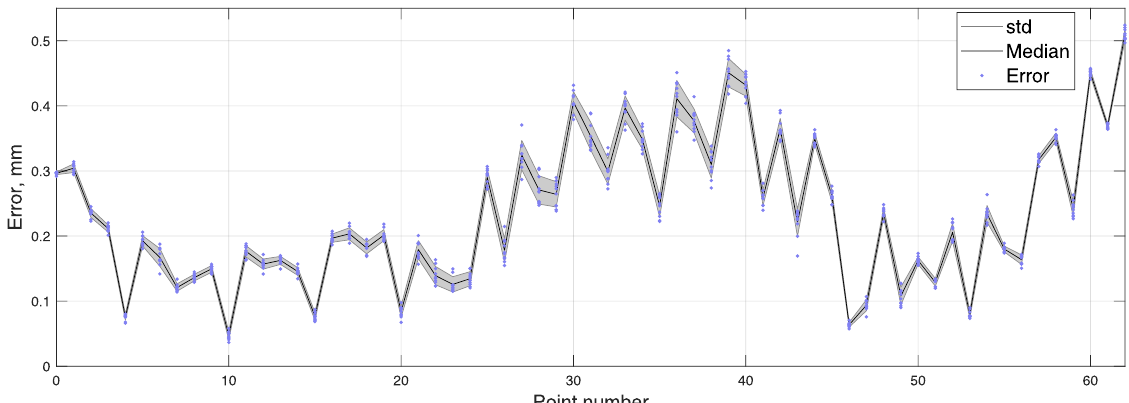
Figure 12. Error of every measured point in 10 iterations of the masticatory test trajectory, with median and standard deviation.